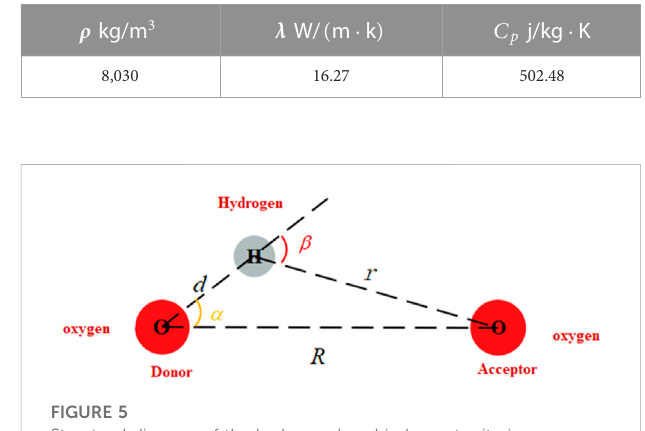
FIGURE 5 Structural diagram of the hydrogen bond judgment